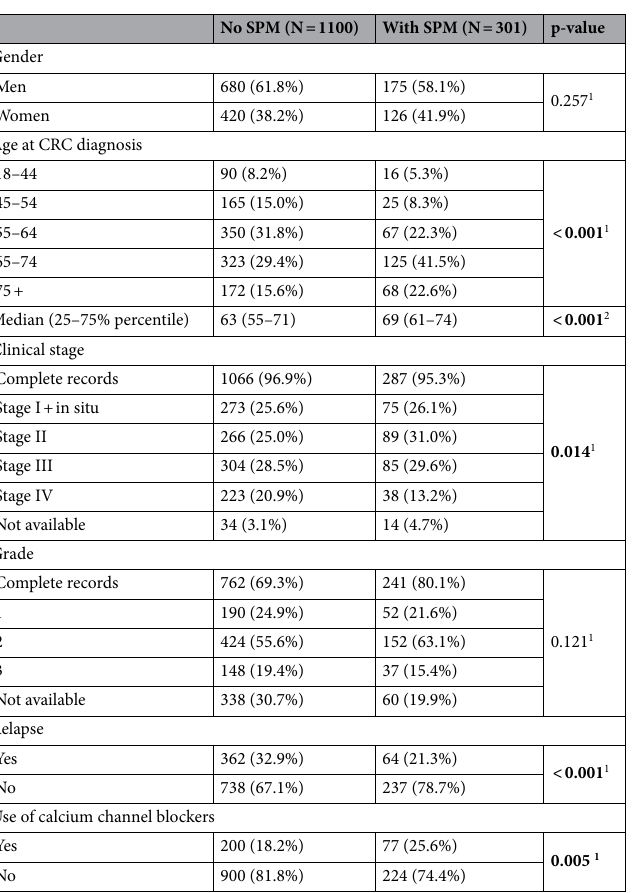
Table 1. Characteristics of colorectal cancer patients (C18–C20) stratified by occurrence of second primary malignancy. SPM second primary malignancy, CRC colorectal cancer. 1 Fischer exact test, 2 Mann-Whitney test. Significant values are bold.